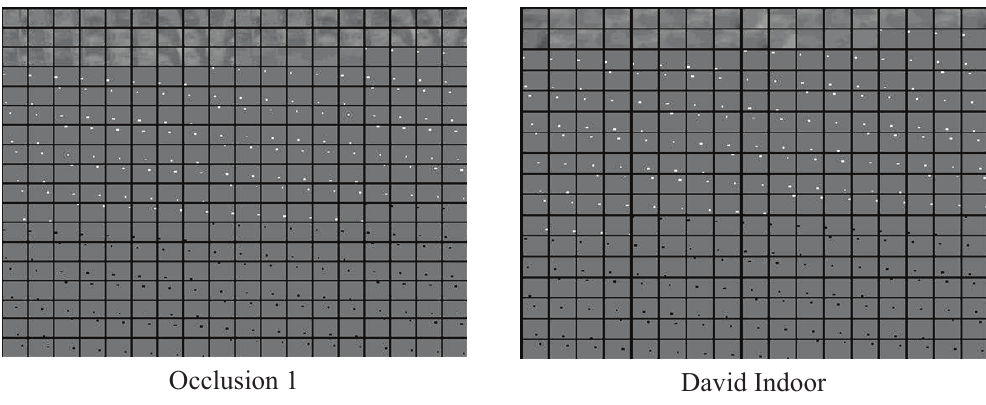
Figure 11. Dictionary of Occlusion 1 and David Indoor learned by IDSDL after 100 frames (best viewed in color).